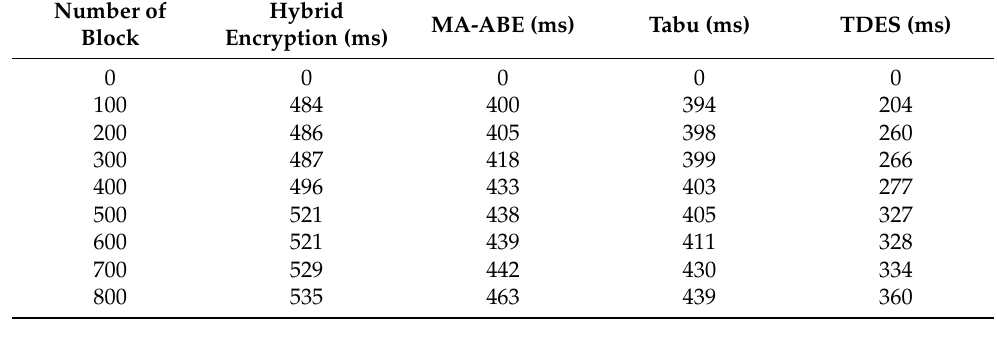
Table 7. Encryption time of TDES and comparison with existing techniques.